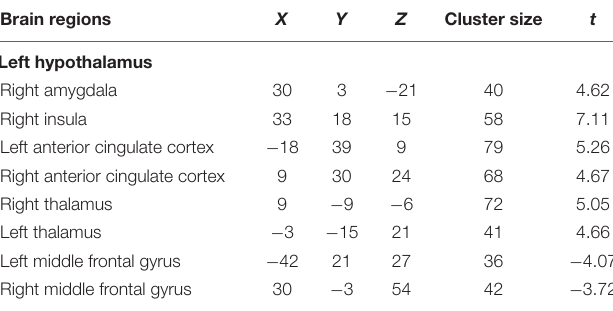
TABLE 2 | Brain regions with significantly altered functional connectivity with hypothalamus after